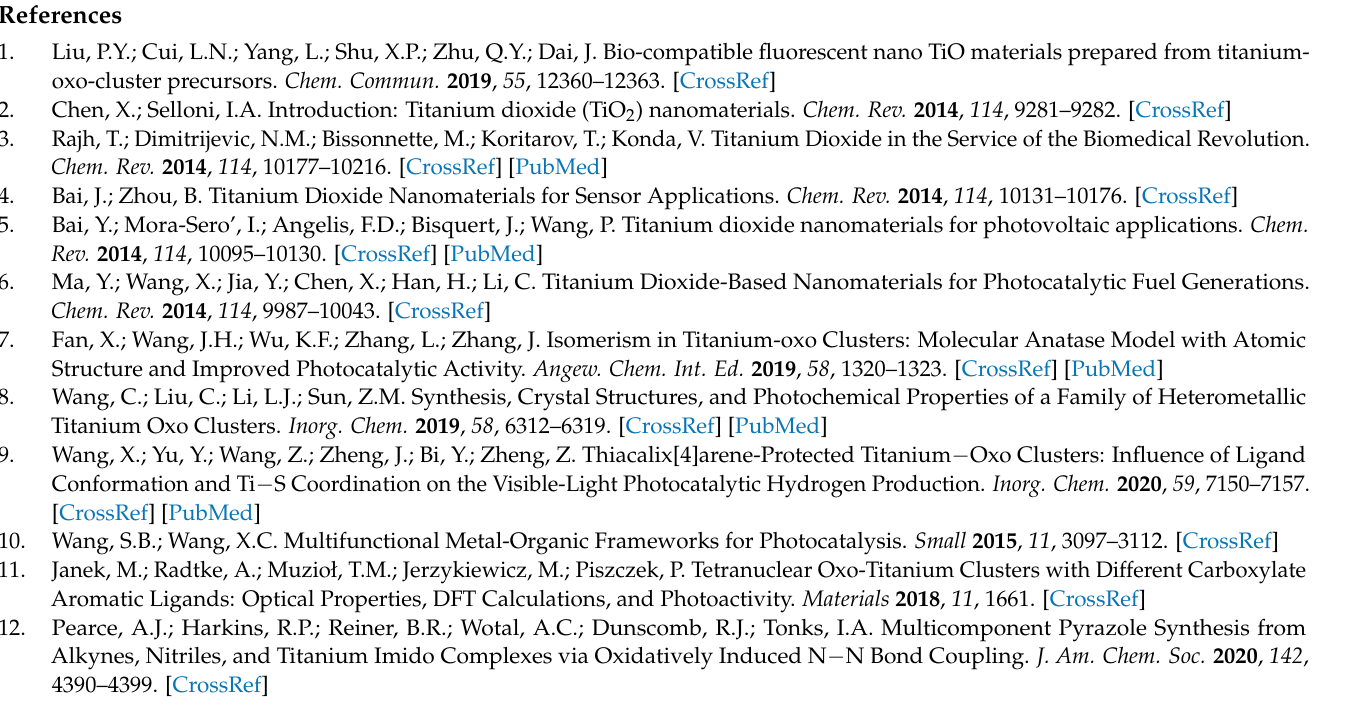
Figure S4: 2D { 1 H} grCOSY of 1 ; Figure S5: 2D { 1 H, 13 C} grHSQC of 1 ; Figure S6: 2D { 1 H, 13 C} grHMBC of 1 ; Figure S7: 2D { 1 H, 13 C} grHSQC of 1 + 4 eq But 4 NOH + 0.1 eq H 2 dihybe; Figure S8: 2D { 1 H, 13 C} grHMBC of 1 + 4 eq But 4 NOH + 0.1 eq H 2 dihybe; Figure S9: Tauc plot of compound 1 ; Table S1: 1 H and 13 C NMR chemical shifts (ppm) for the ligand H3dihybe, the minor titanium species 2 and the shielding/deshielding effect ( ∆ δ ) upon complexation; Table S2: 1 H and 13 C NMR chemical shifts (ppm) for 1 and H2dihybe after addition of three equivalents of But4NOH per 1 and the shielding/deshielding effect ( ∆ δ , ppm) upon complexation. The following are available online, Supporting Information (pdf) containing crystal data. CIF files containing crystal data for complex 1